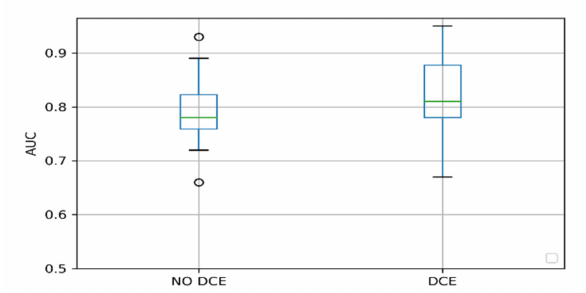
Figure 4. Model performance boxplots grouped by inclusion of the dynamic contrast-enhanced (DCE) sequence for model